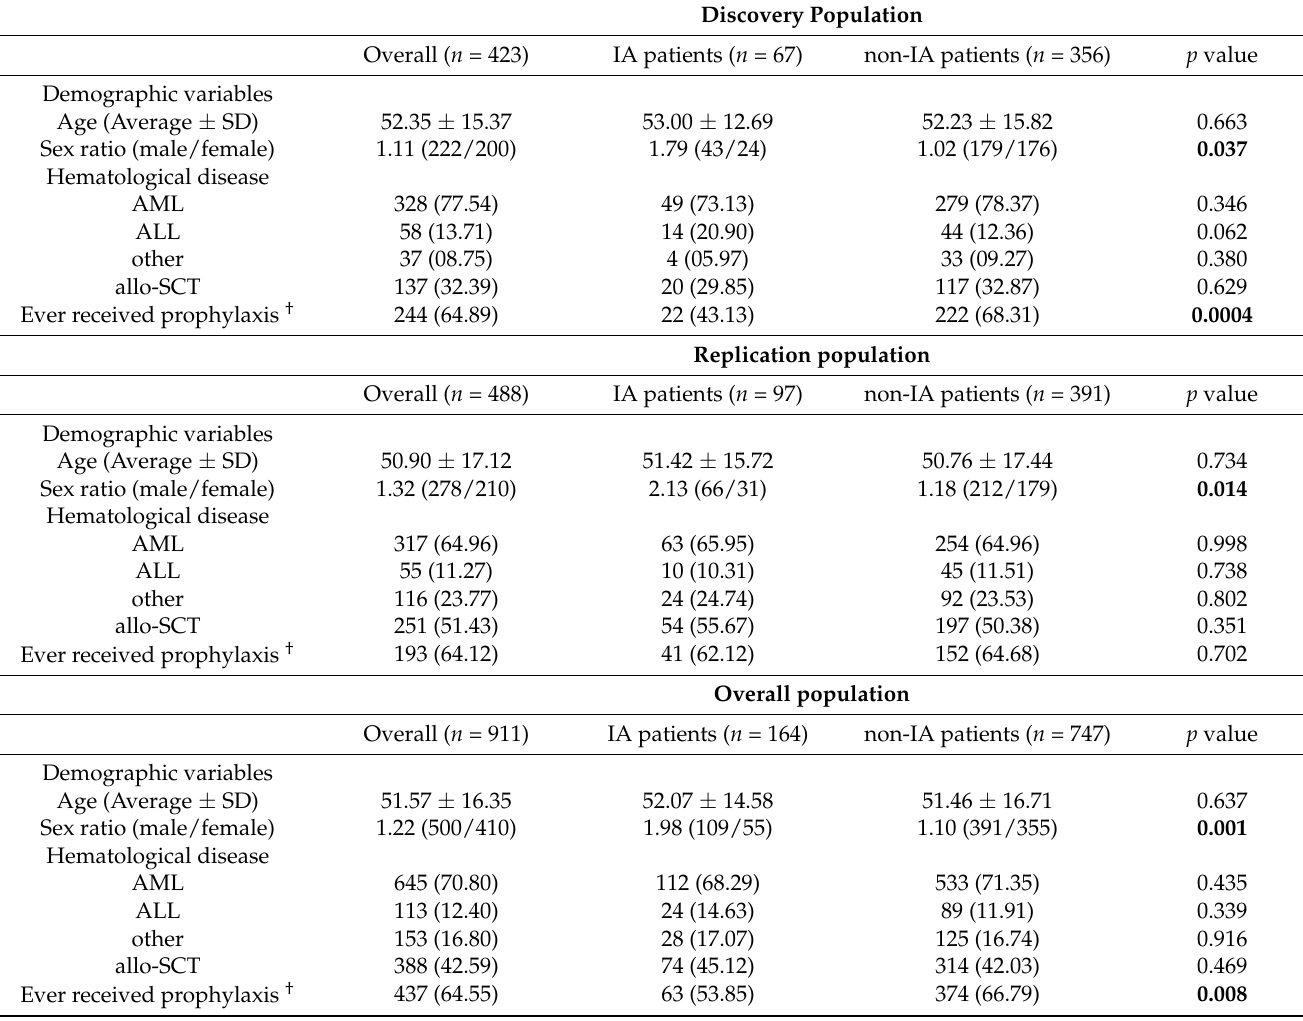
Table 1. Baseline and clinical characteristic of patients with or without invasive aspergillosis (IA).